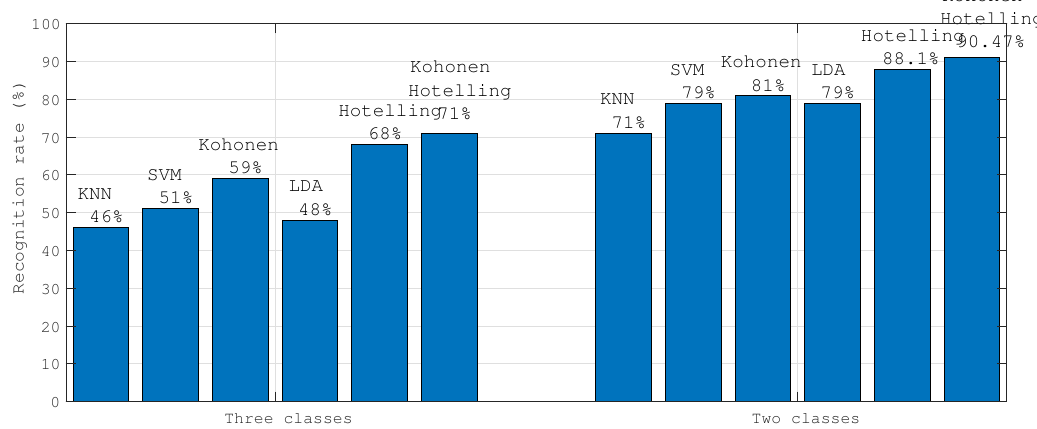
Figure 7. Comparison of the proposed sample-encoding Kohonen network method with other classifiers using a leave-one-out cross validation